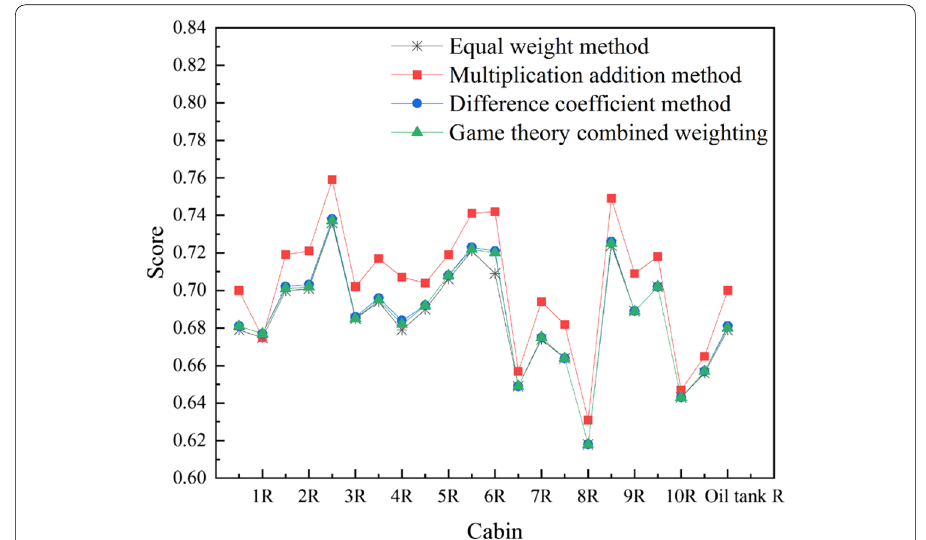
Fig. 3 Fuzzy comprehensive evaluation